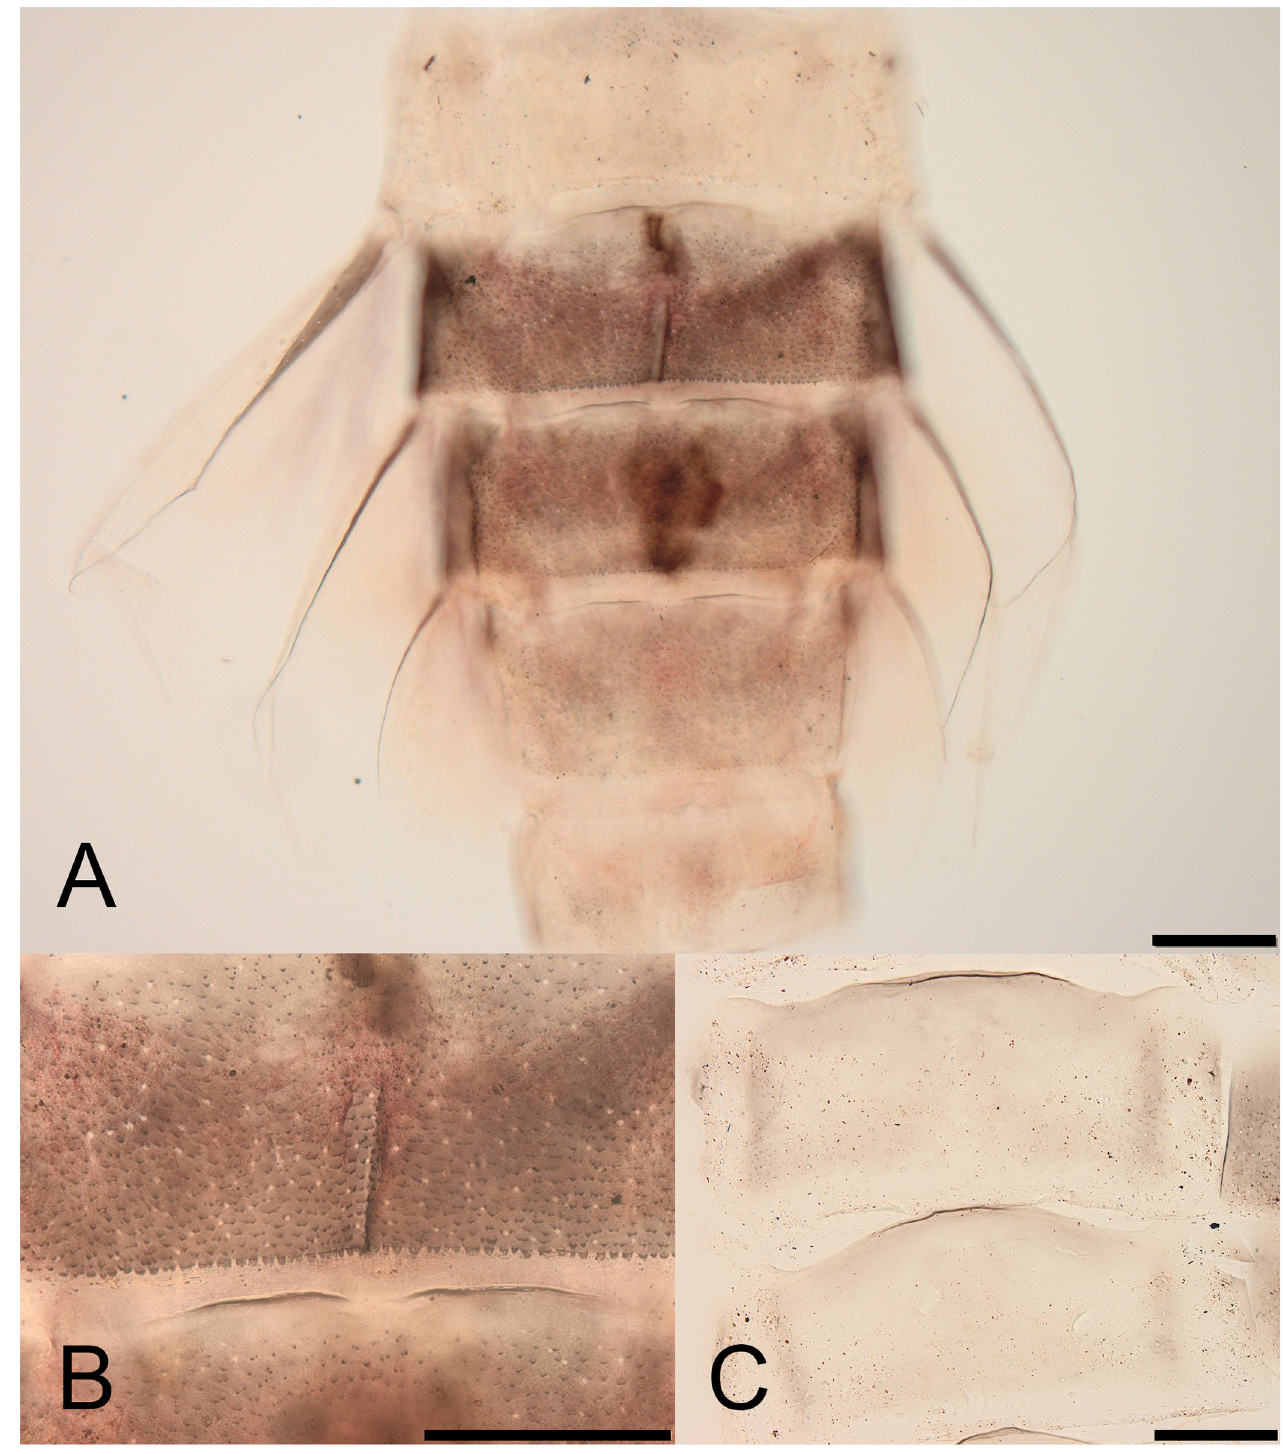
Fig 6. Cymbalcloeon sartorii gen. nov. et sp. nov. Larval morphology. (A) abdomen segments V–IX, (B) tergum VI, (C) sterna II–III. Scale bar: 0.1 mm.